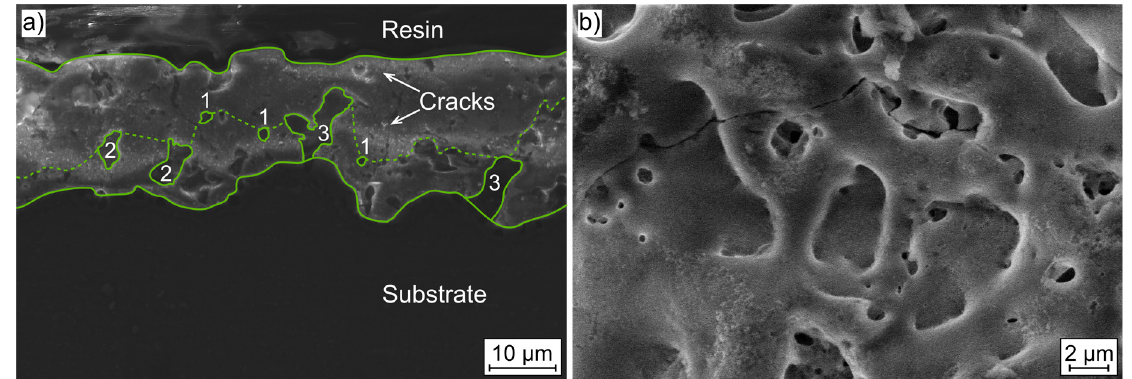
Figure 3. Results of microstructural investigations of plasma electrolytic oxidation (PEO) coating on Mg WE43 MEO: 3 ( a ) SEM image of cross section: (1) circular pores, (2) arbitrarily formed pores, (3) arbitrarily formed pores with connection to the substrate material ( b ) SEM image of top